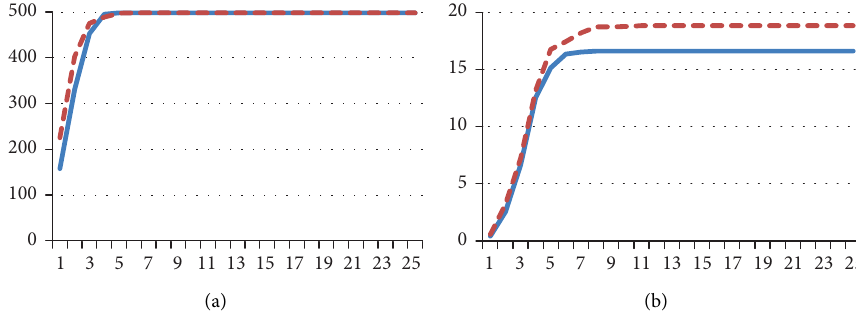
Figure 3: Comparison of the difusion of NEV with the diferent innovation capabilities of opinion leaders: (a) difusion of information and (b) difusion of